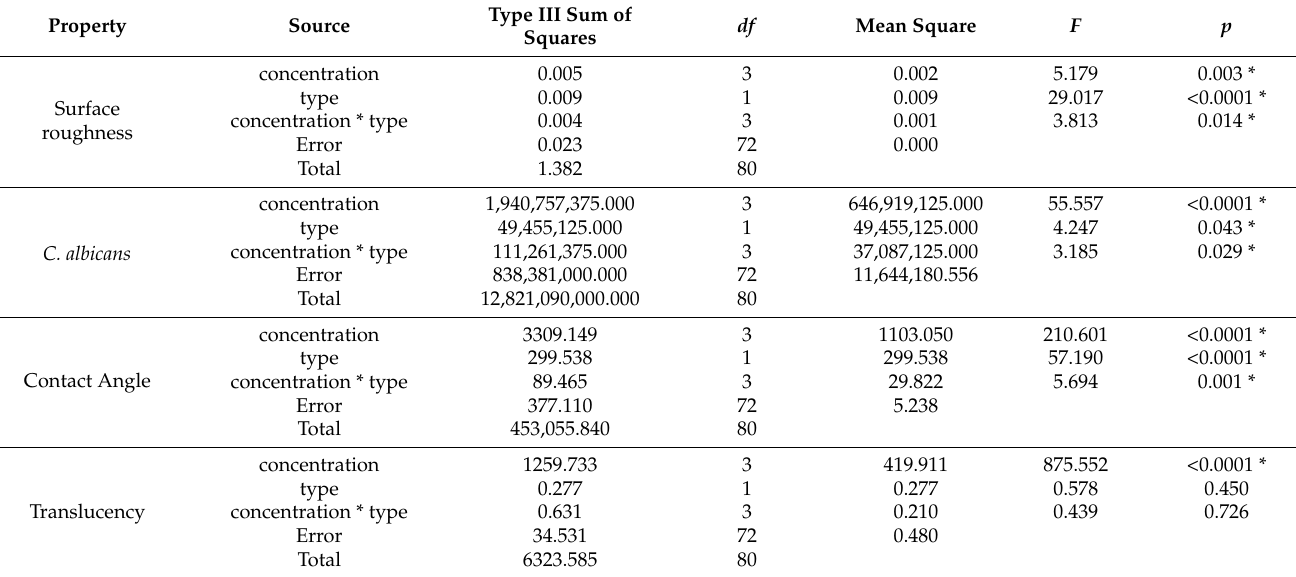
Table 3. Combined effect of ND concentration and polymerization methods using two-way ANOVA.